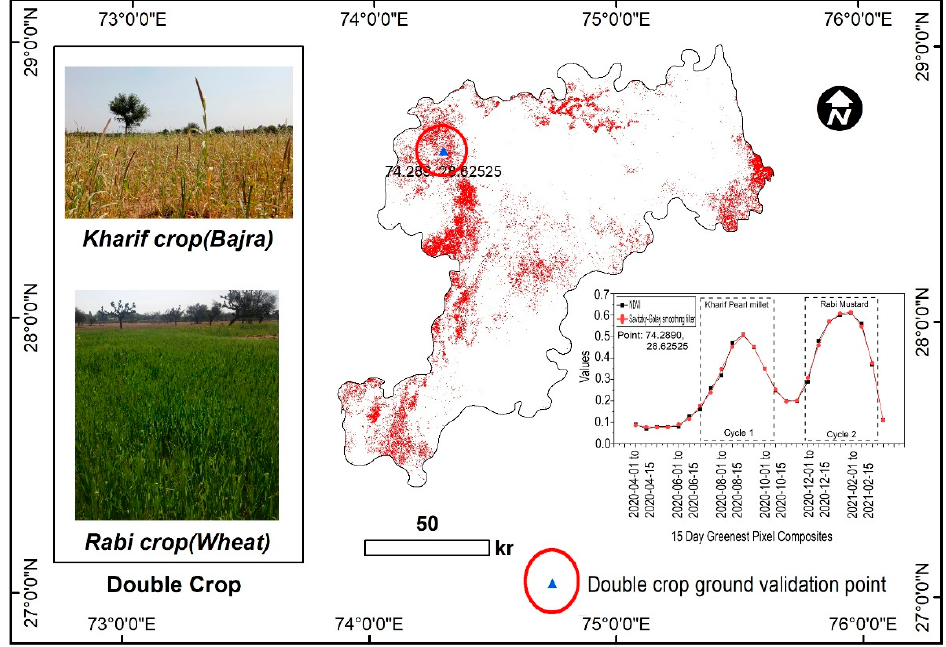
Figure 15. Double crop ground validation point example with photograph (Datum: WGS84).